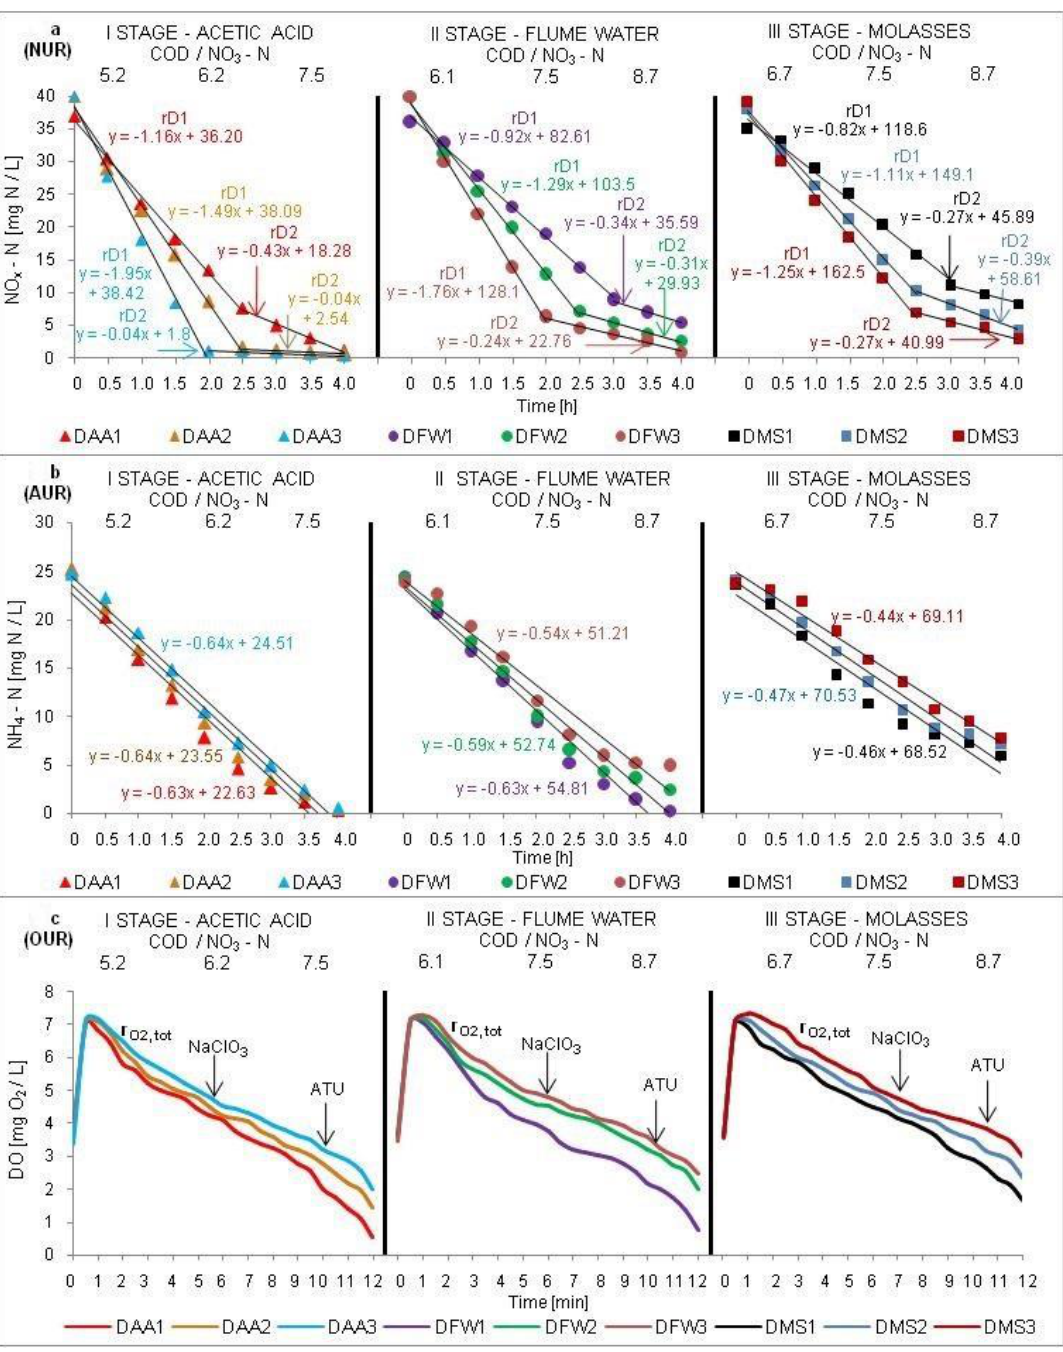
Figure 4. Profiles of changes in concentrations of NO x – N ( a ), NH 4 – N ( b ), and DO ( c ) used to calculate SNUR, SAUR, and SOUR values, respectively; where, r D1 is the denitrification rate on S s (the readily biodegradable COD fraction), X s (the particulate COD fraction), and endogenous respiration r D2 is the denitrification rate on X s and endogenous respiration.